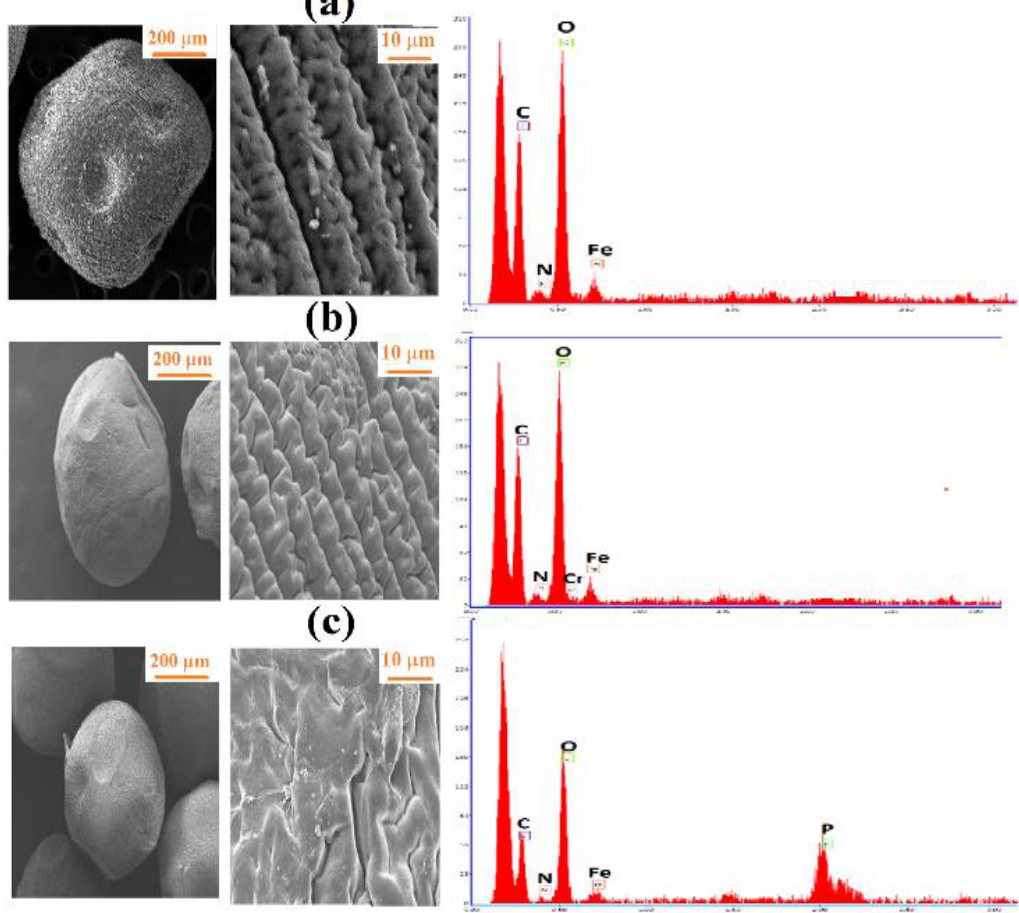
Figure 3. ( a ) SEM images at different resolutions and EDX spectra of ( a ) Fe–CTB microbeads ( b ) after Cr(VI) adsorption and ( c ) after phosphate adsorption.